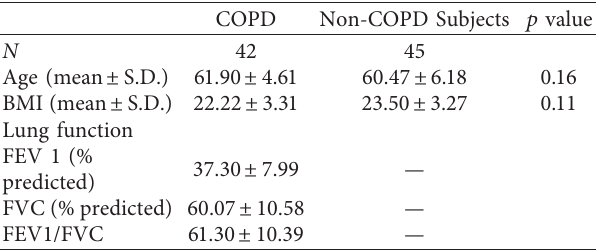
Table 1: Demographic data of the